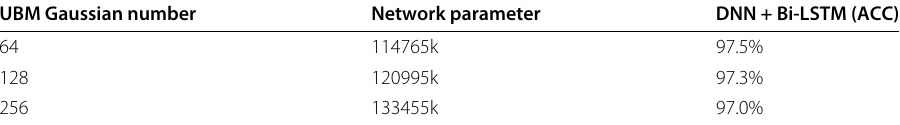
Table 4 Comparison experiment based on the effectiveness of UBM Gaussian number